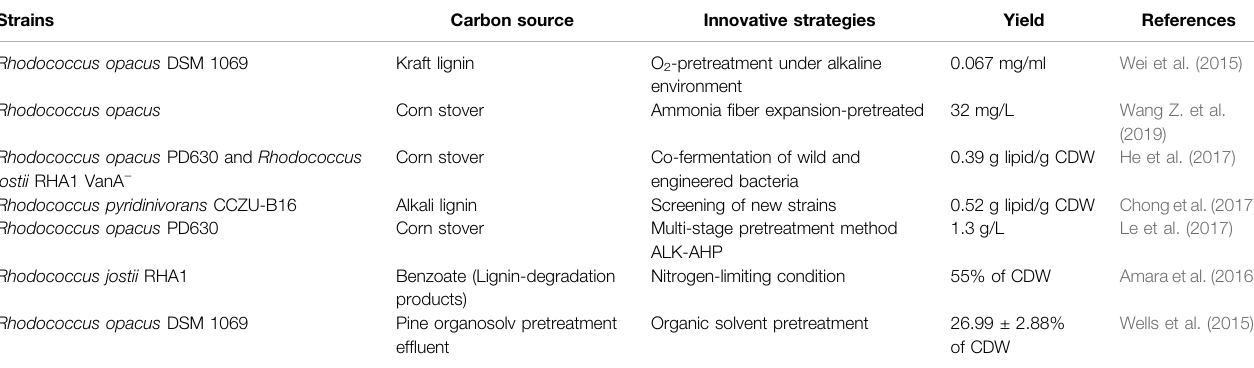
TABLE 1 | Biosynthesis pathways of lignin to lipids through bacteria.